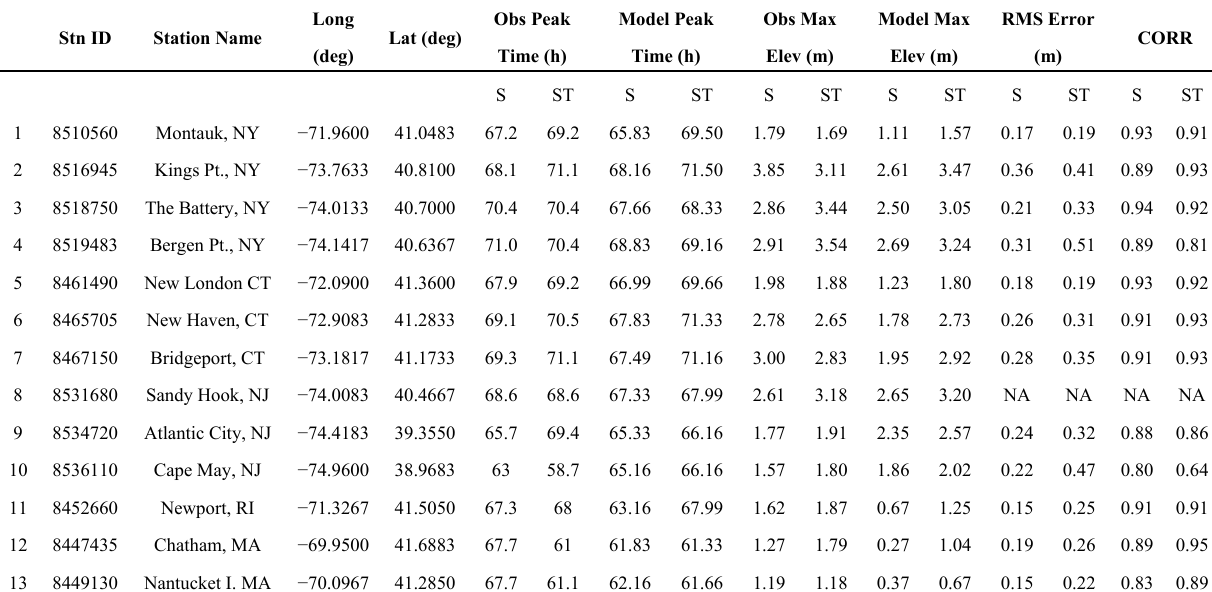
Table 4. Summary of the NOAA stations vs. SLOSH surge (S) and surge-plus-tides (ST) 27 October 2012. The numbers in column 1 correspond to the locations shown in Figure 2 and the time series plots in Figure